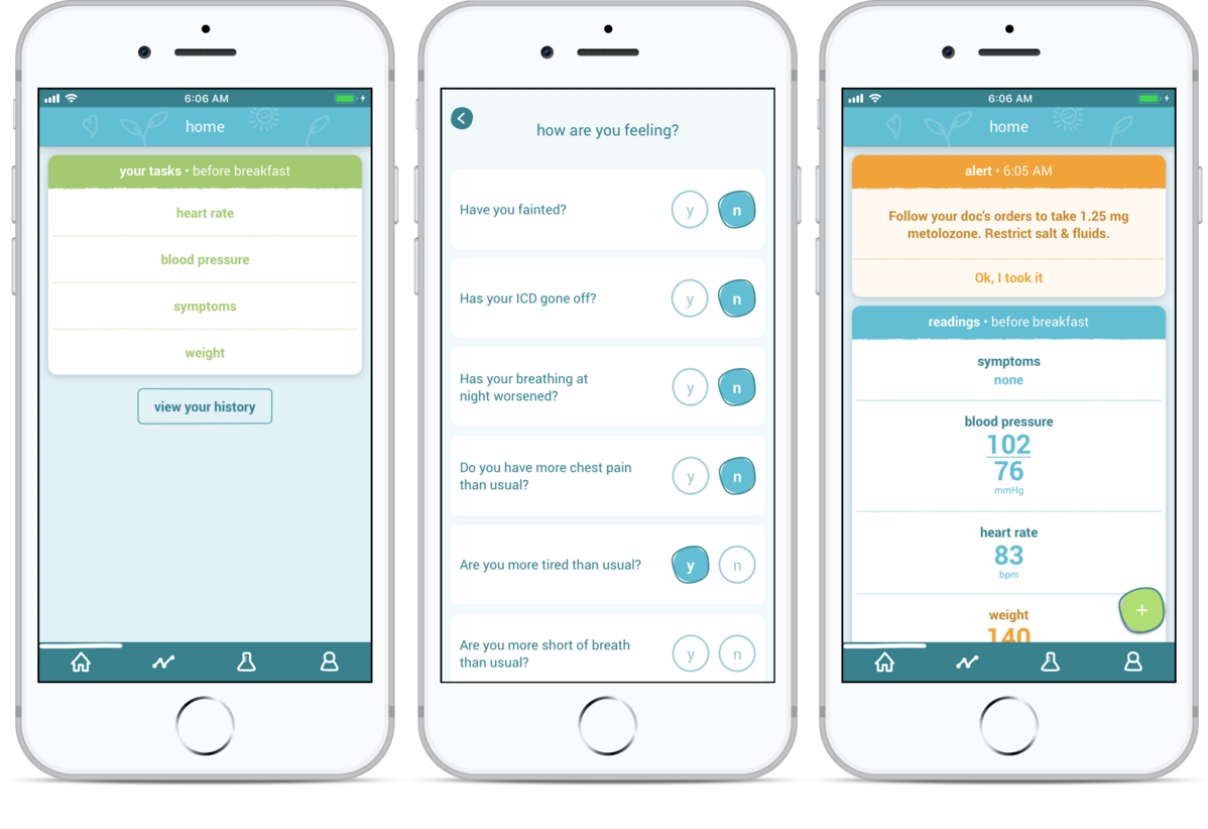
Figure 1. Pages of the Medly app showing the incomplete morning card with required readings, the symptoms questionnaire, and personalized self-care feedback after all 4 readings were taken and processed by the